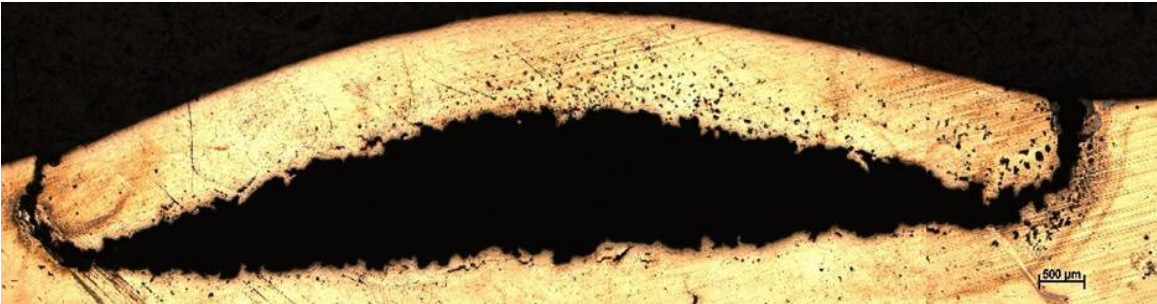
Figure 7. Panorama of the spall fracture of an additive thermal-treated sample (AAT) of Inconel 718 alloy after impact along the direction of surfacing (×25). 718 alloy after impact along the direction of surfacing ( ×